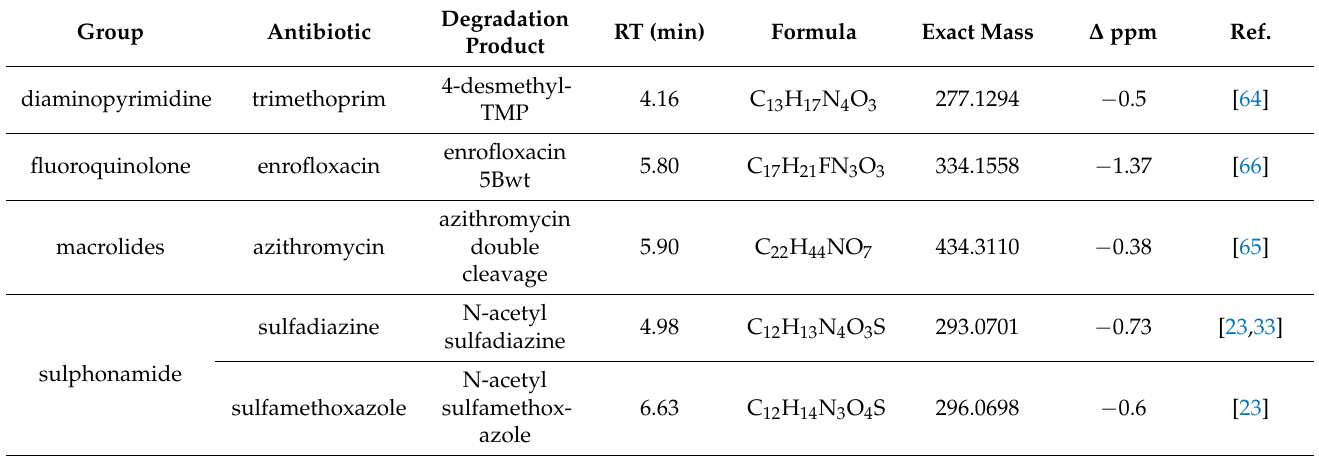
Table 5. The antibiotic degradation products detected.